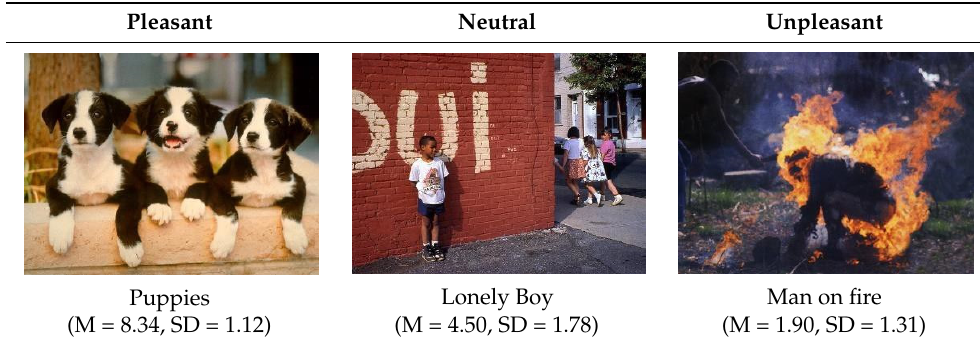
Table 1. Sample IAPS images used in the baseline portion of the experiments.